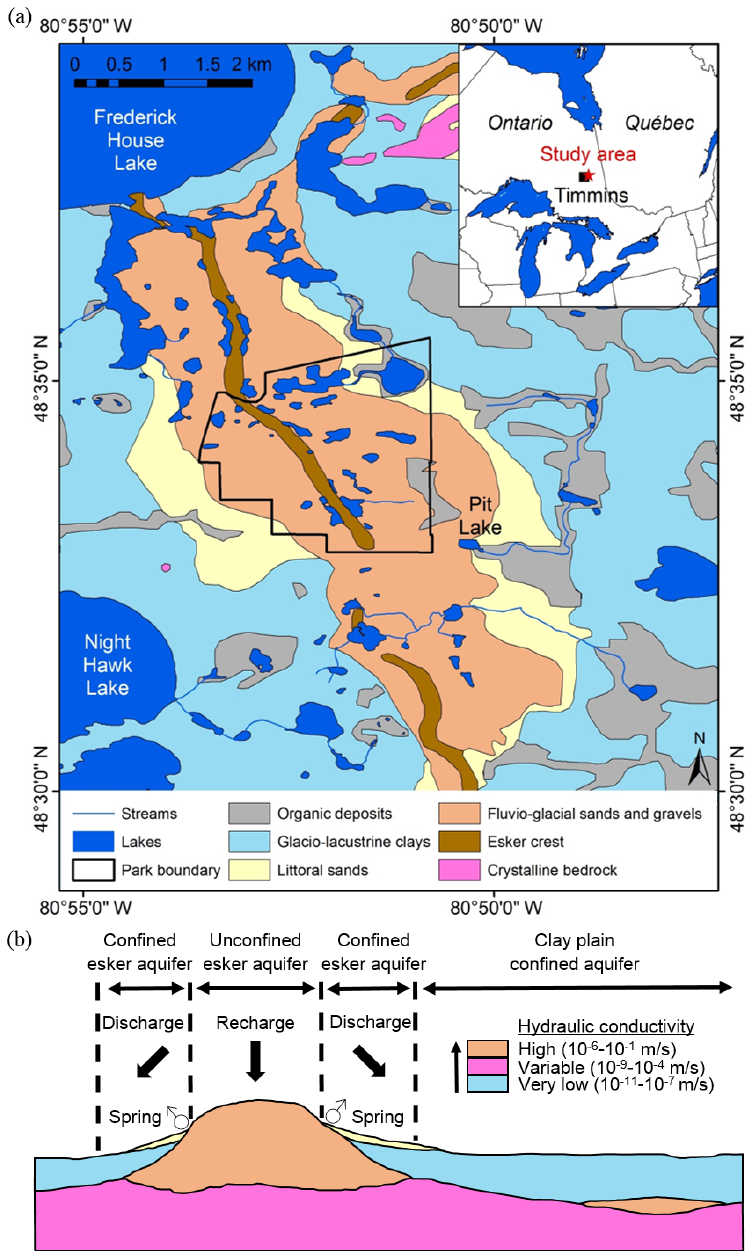
Figure 1. Location of the study area in northeastern Ontario near Timmins, Ontario (based on Richard and McClenaghan, 2000; © Queen’s Printer for Ontario, 2021) (a) , and conceptual geological transverse section of an esker complex at latitude 48 ◦ 35 (cid:48) 0 (cid:48)(cid:48) N (b) (figure modified from Cloutier et al., 2007; hydraulic conductivity values from Cloutier et al.,